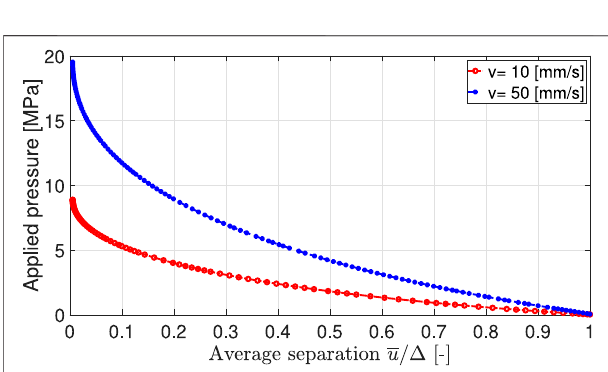
FIGURE 2 | Typical average applied pressure vs separation curves (separation in dimensionless units), obtained in the case of adhesionless sliding contact between a (two-dimensional) sinusoidal rigid surface and a viscoelastic slab, for two sliding speeds. Δ is the amplitude of the sinusoidal rigid surface, however, for a generic randomly rough contact it is given by the combined root-mean-square-roughness of the interface.